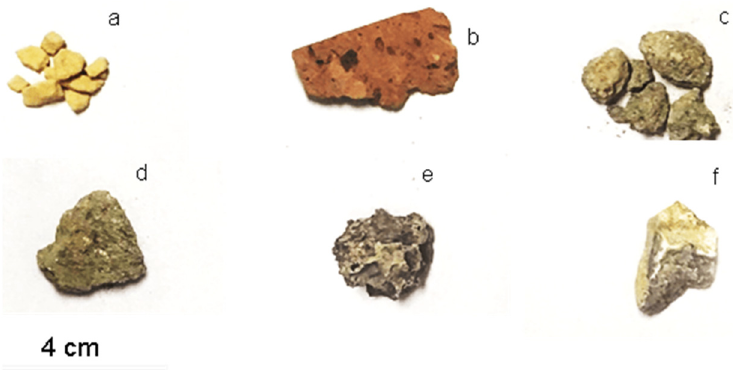
Figure 3. Images of macro samples: ( a ) yellow brick, sample B3; ( b ) red brick, sample B4; ( c , d ) mortars, samples M1 and M2, respectively; ( e ) pumice, sample P1; ( f ) marble, sample MA1.